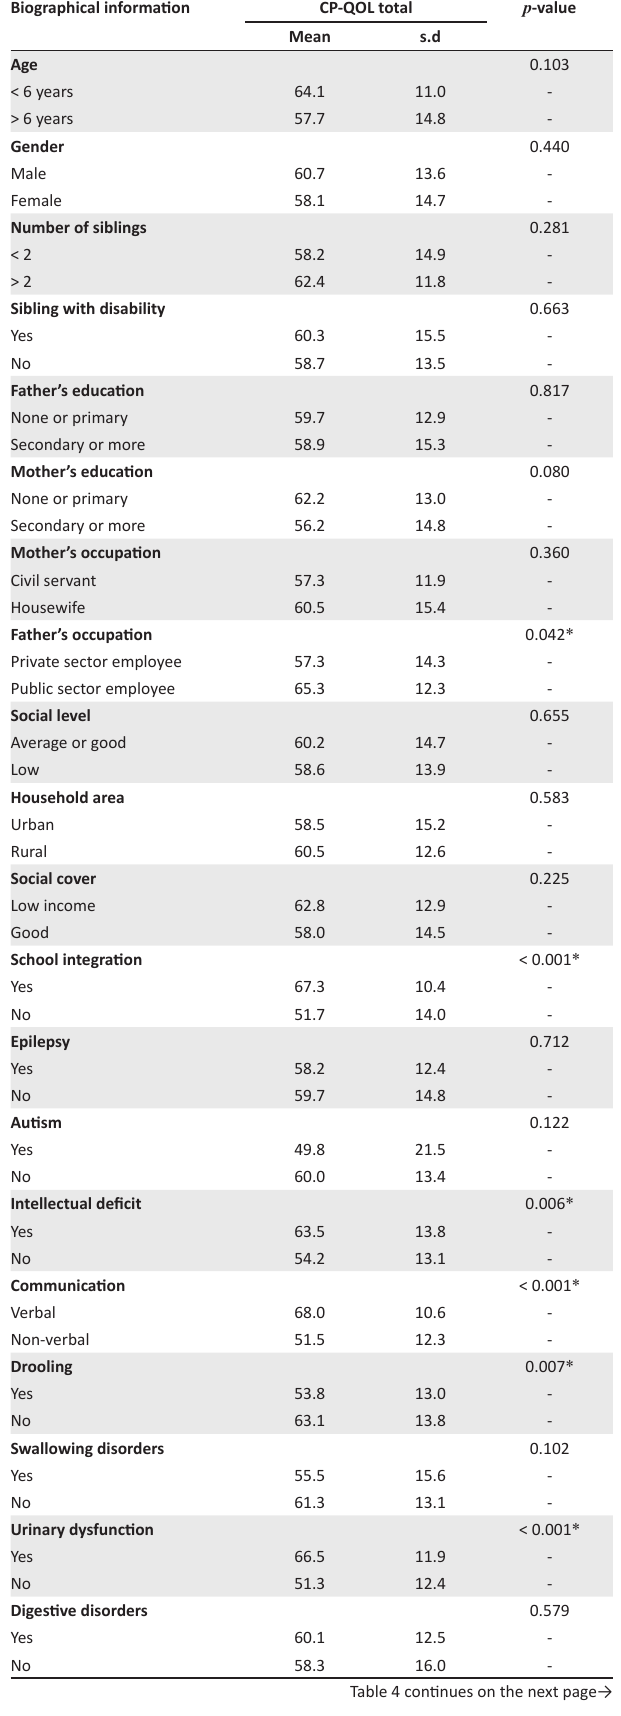
TABLE 3: Comparison of the results of the cerebral palsy quality of life-child calculated from the two versions in children with cerebral palsy aged over 9 years with normal intellectual capacities and possible verbal communication.